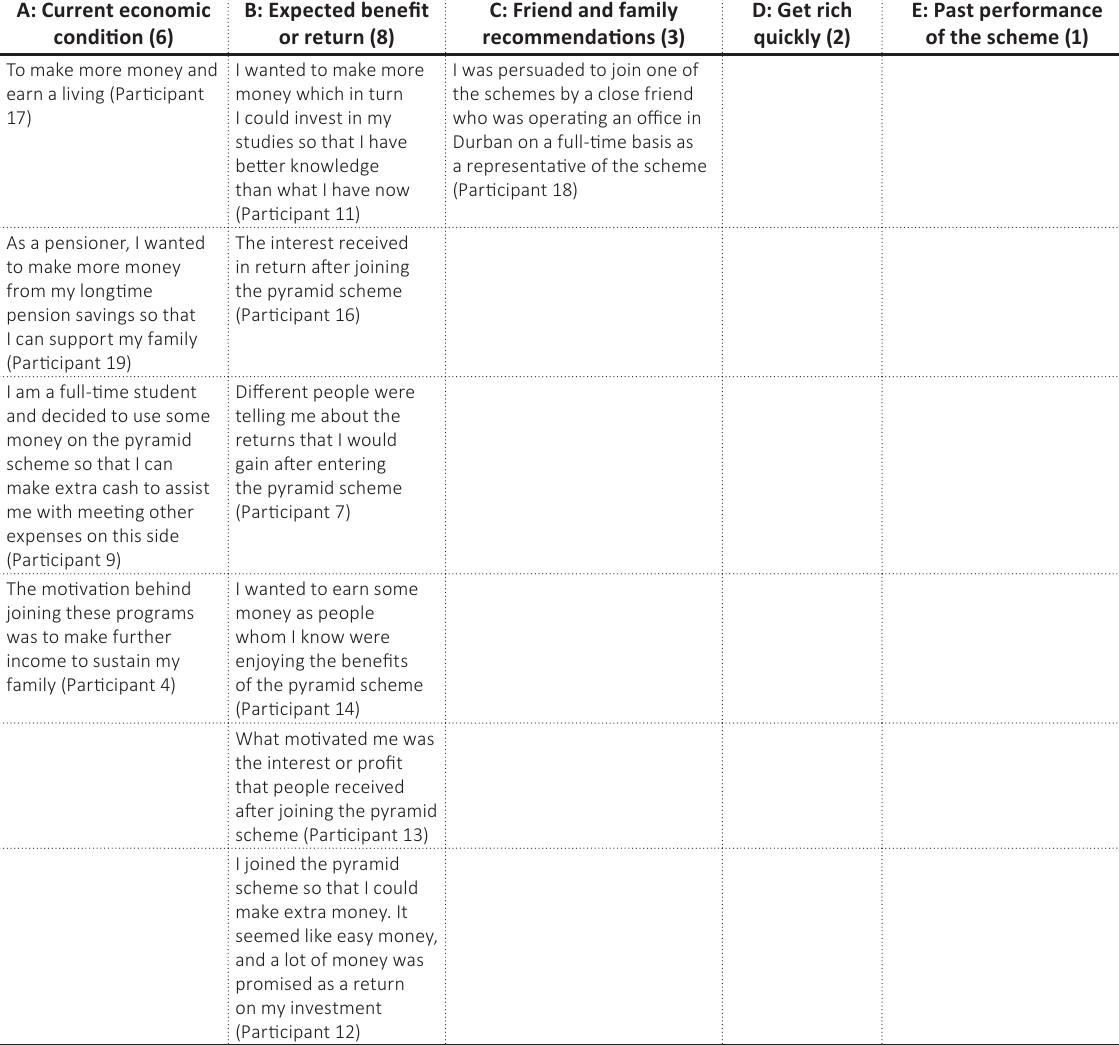
Table 2 (cont.). Framework matrix on the emerging themes and